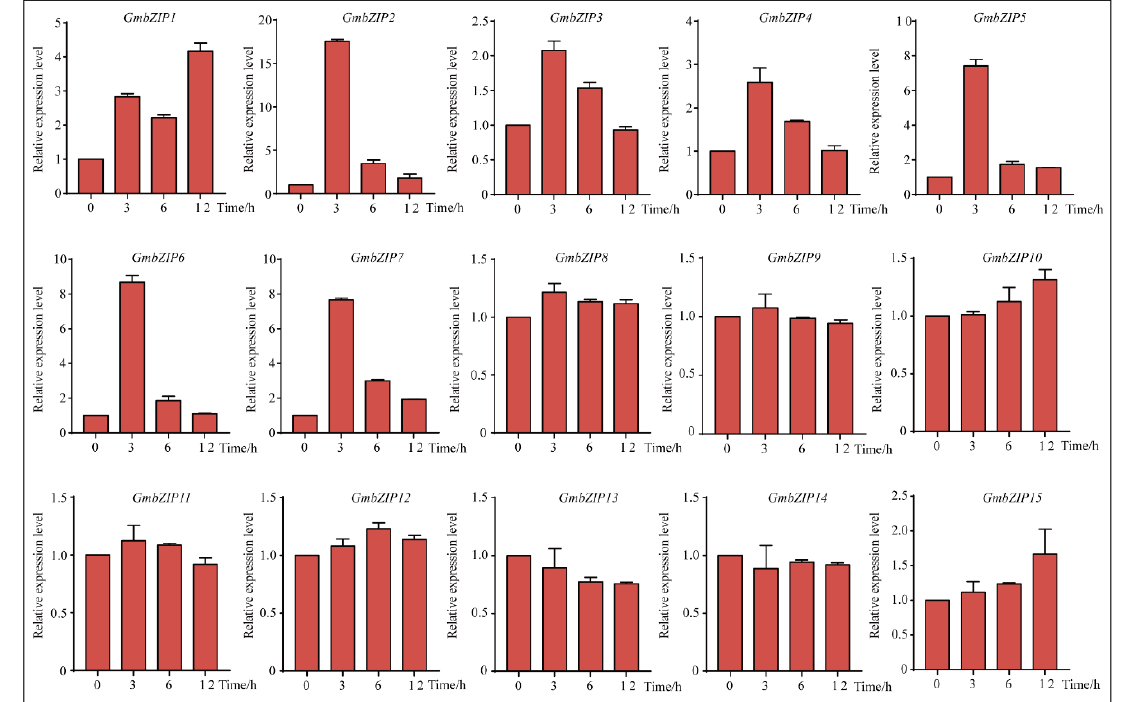
Figure 6. Expression patterns of the 15 GmbZIP genes under salt treatment. qRT-PCR data are normalized using soybean Actin ( U60506 ) and displayed as relative to 0 h. The X-axes show time periods and y-axes depict scales of relative expression level (error bars indicate SD).